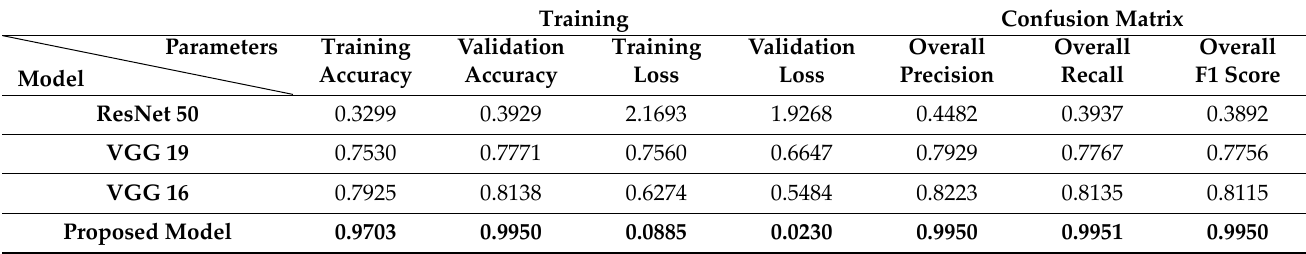
Table 4. Comparison of models.